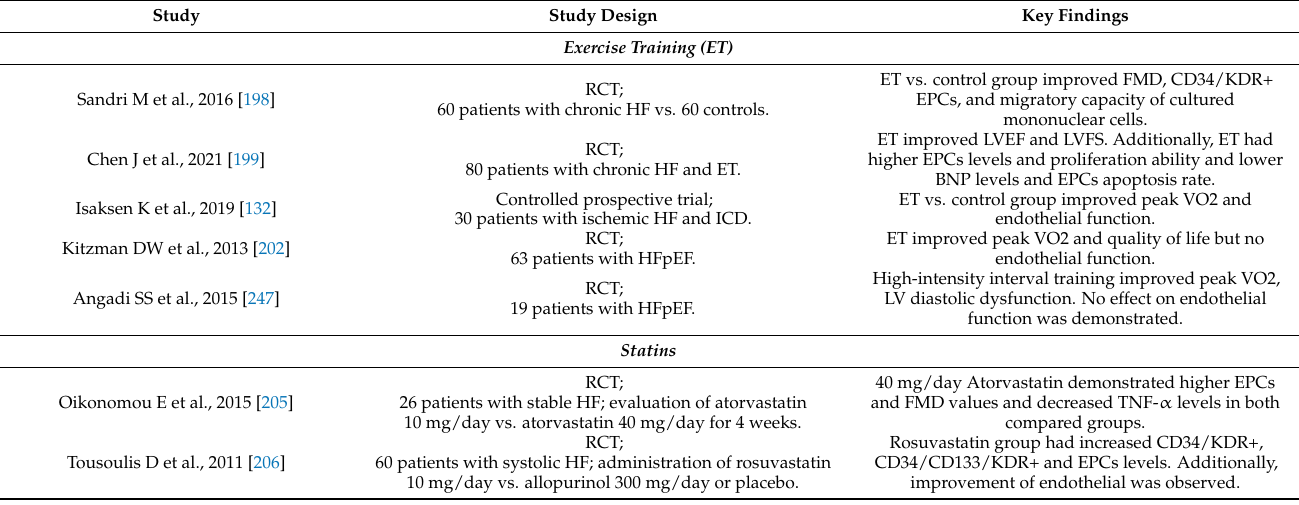
Table 1. Therapeutic options for the treatment of endothelial dysfunction in patients with heart